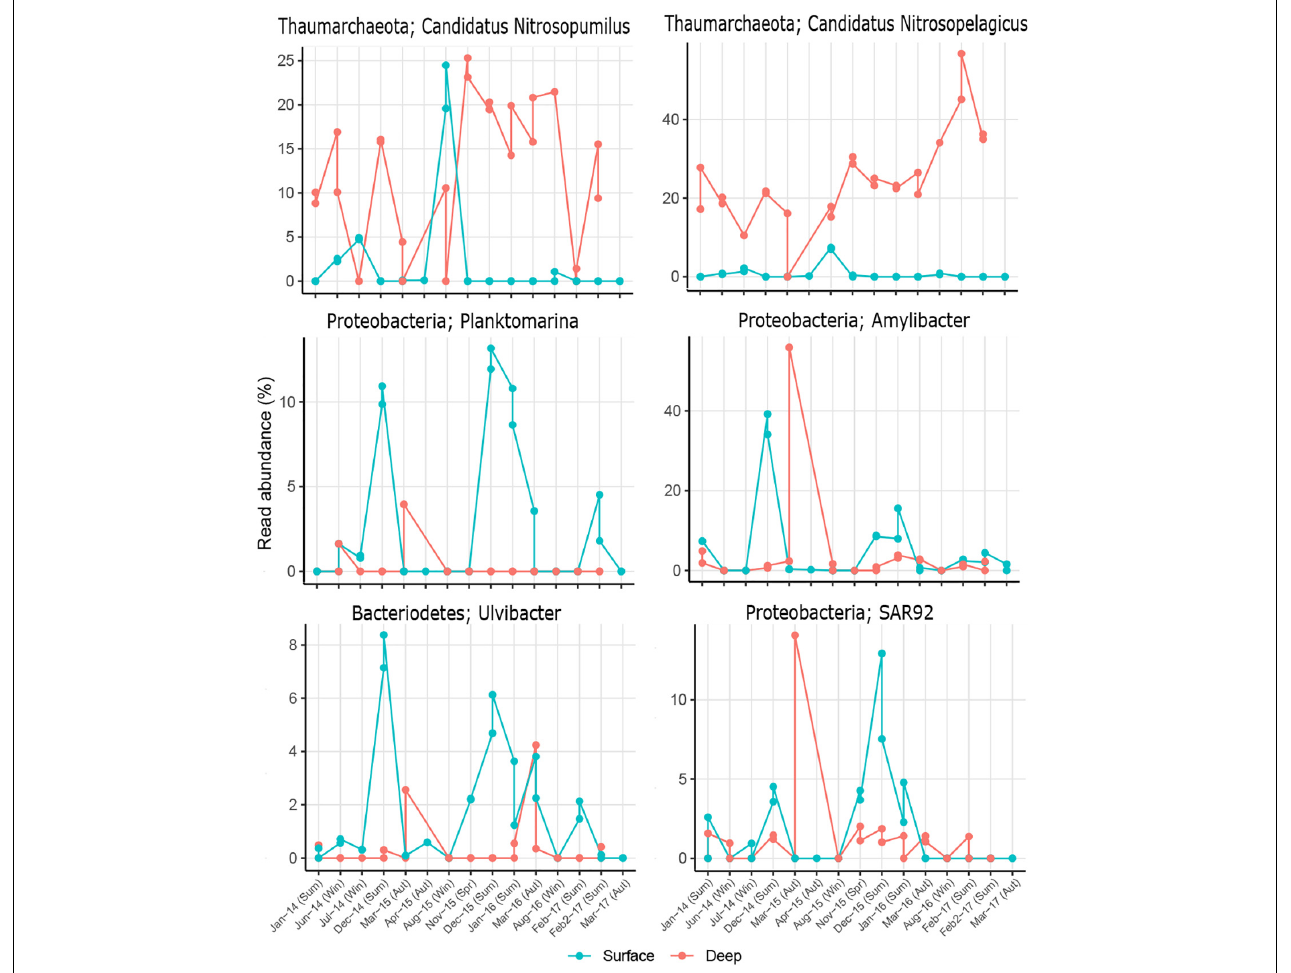
FIGURE 5 | Seasonally changing taxa determined from a generalised linear model showing potential linkages between surface and deep (500 m) waters either by deep water mixing during winter ( Candidatus Nitrosopumilus , Candidatus Nitrosopelagicus ) or by sinking from the surface as indicated by a lag in peak abundance in deep waters ( Planktomarina , Amylibacter , Ulvibacter , and SAR92 ). Samples were collected over 3 years from the Munida Microbial Observatory Time-Series (MOTS) with sampling dates and their corresponding meteorological season indicated as Spr, spring; Sum, summer; Aut, autumn, and Win, winter.